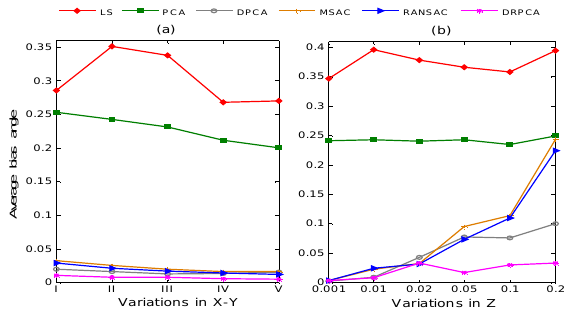
Figure 4. Average bias angle w.r.t. (a) point density variation (b) z variation The above results in bias angle show that RANSAC performs better than MSAC in most of the cases, and DRPCA out performs DPCA. In the interests of brevity we do not consider DPCA and MSAC in the rest of the